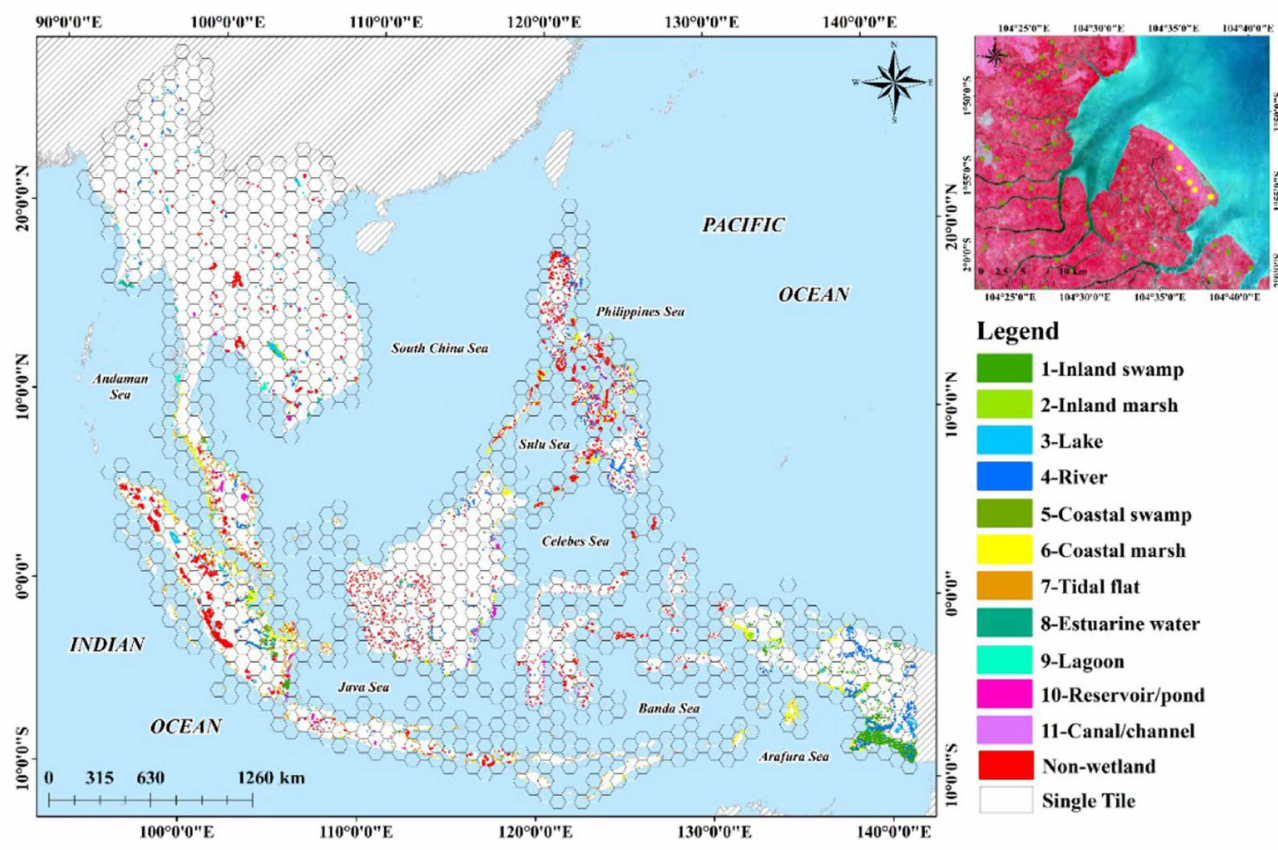
Figure 8. The spatial distribution of